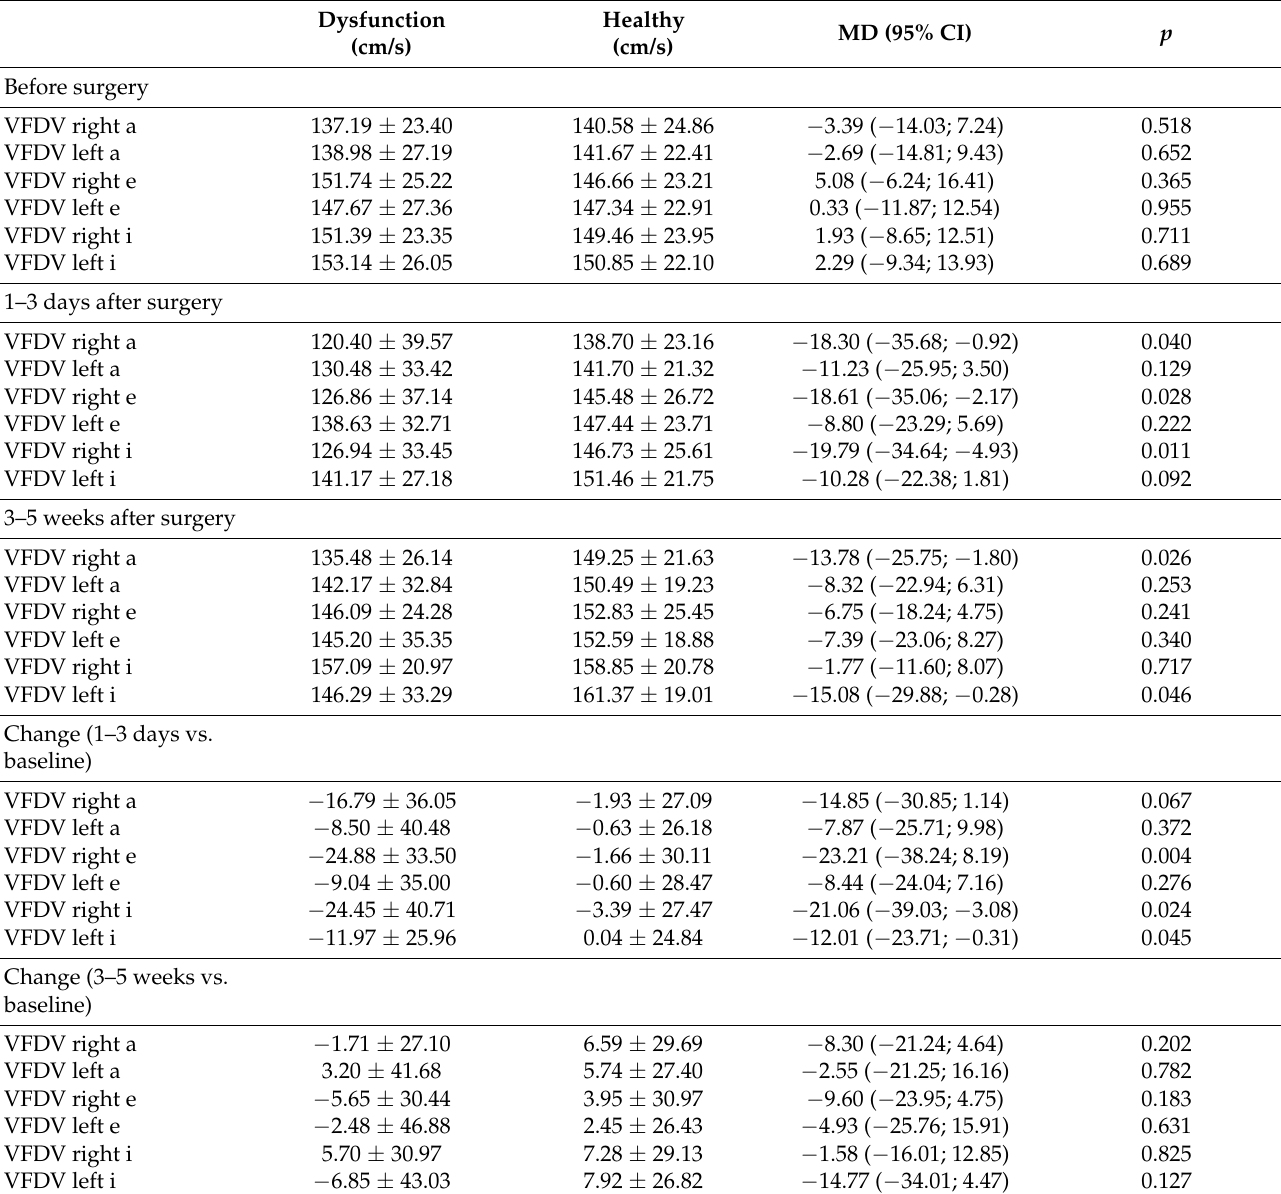
Table 4. Vocal fold displacement velocity between healthy and dysfunctional